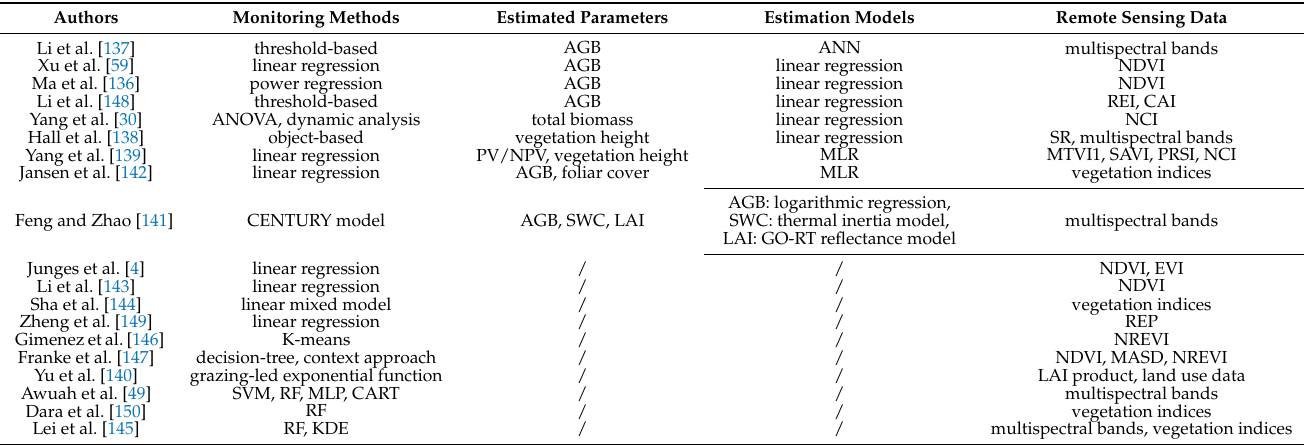
Table 7. Detailed information on the involved monitoring studies for grazing